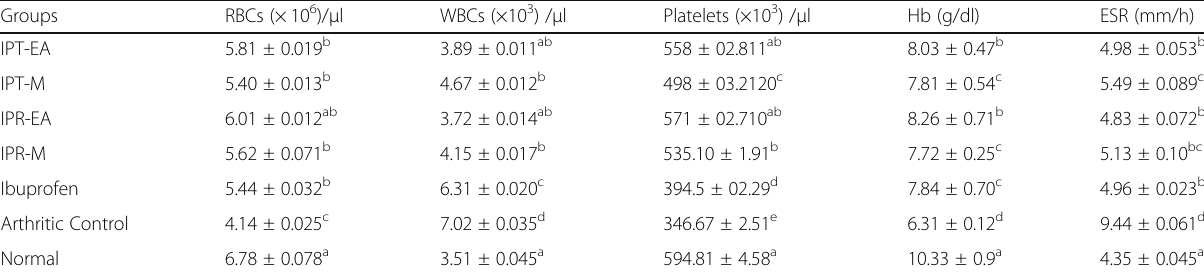
Table 7 The haematological investigation of normal control and arthritic rats